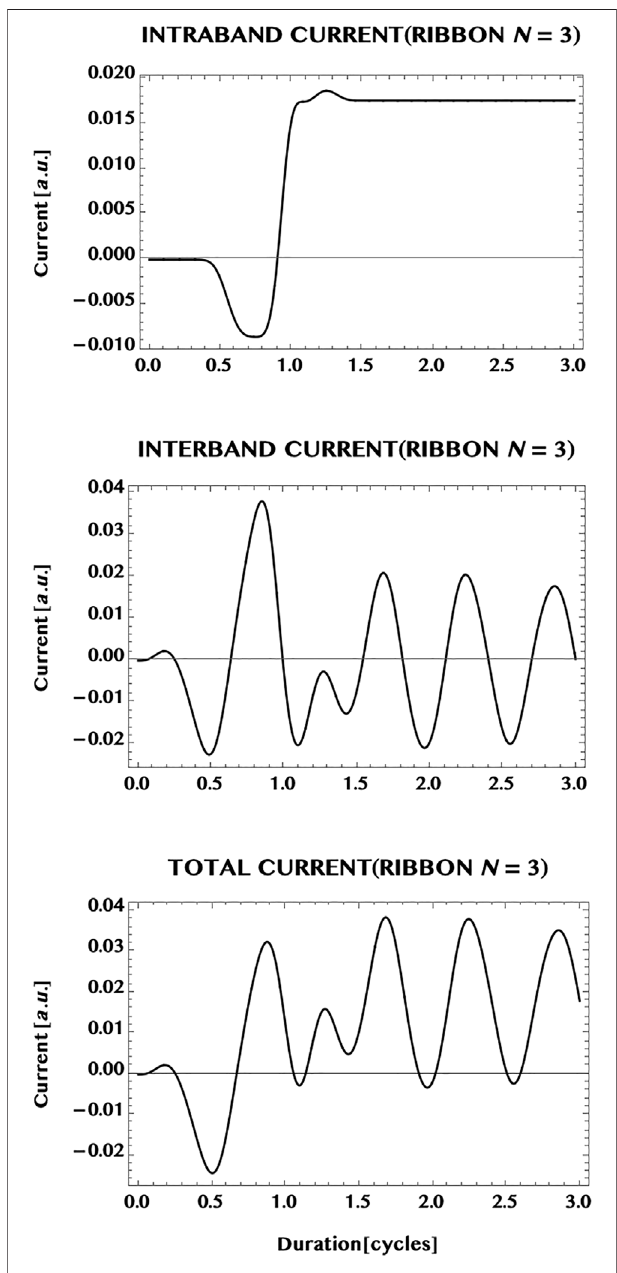
FIGURE10| Normalisedcurrentgeneratedinanarmchairribbon(N=3) by an ultrashort laser pulse (wavelength = 800 nm, intensity = 1 TW/cm 2 , pulse duration=1.5cycles,CEP=0;simulation period=3cycles).Toppanel: intra band current; middle panel, inter band current; bottom panel: total current. Note that the total current is dominated by the inter band ( “ coherent ” ) current that shows an oscillatory behaviour during and after the pulse. This might be understood as an effect of the con fi nement of the ribbon along the width dimension, resulting in a reduced band dispersion in the 1D ribbon compared to the fully open 2D